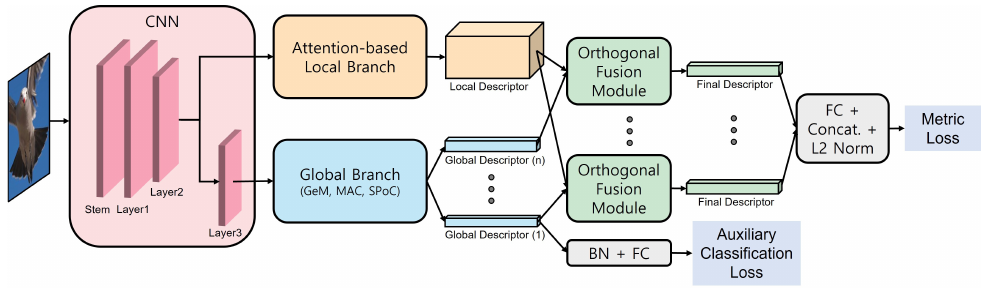
Figure 1. The full architecture of the